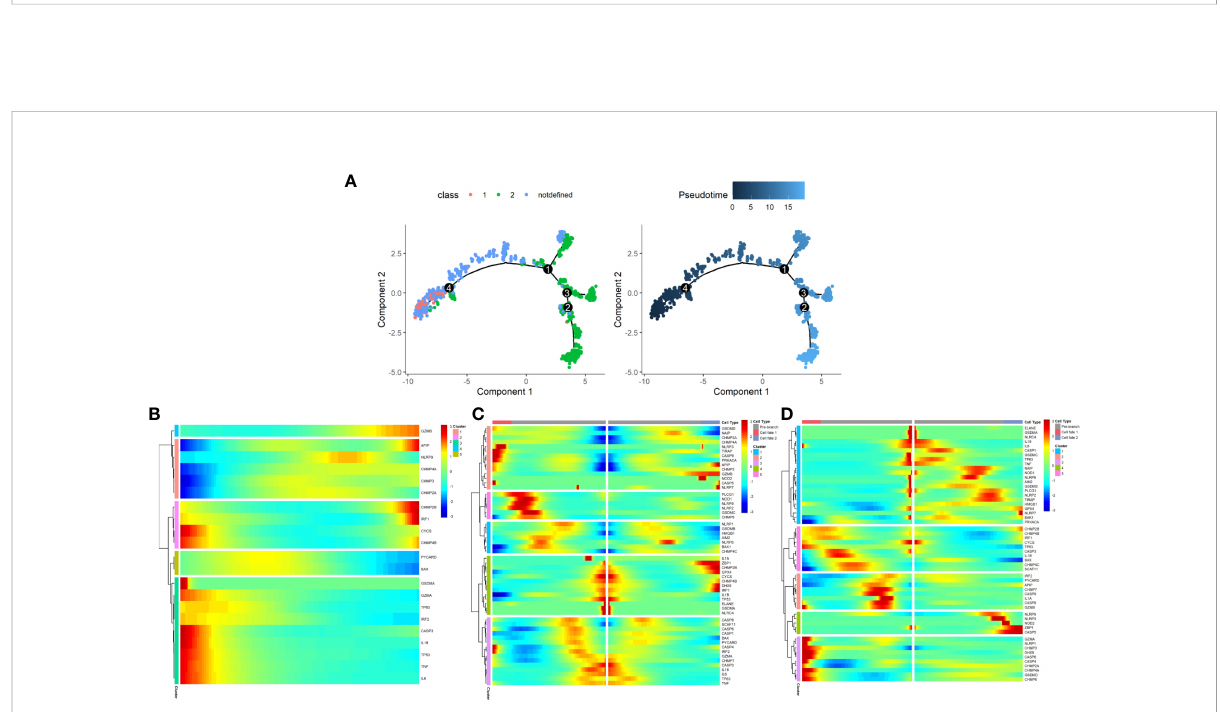
FIGURE 12 The development trajectory and dynamic change of two Classes of maligant epithelial cells. (A) Pseudotime analysis reveals the development trajectories of the two Class of maligant epithelial cells (From Class1 to Class2). (B) The dynamic change of the expression of pyroptosis-related genes during the development of maligant epithelial cells (Timeline from left to right). (C) Heatmap shows pyroptosis-related genes involved in the differentiation of maligant epithelial cells (branch point1). (D) Heatmap shows pyroptosis-related genes involved in the differentiation of maligant epithelial cells (branch